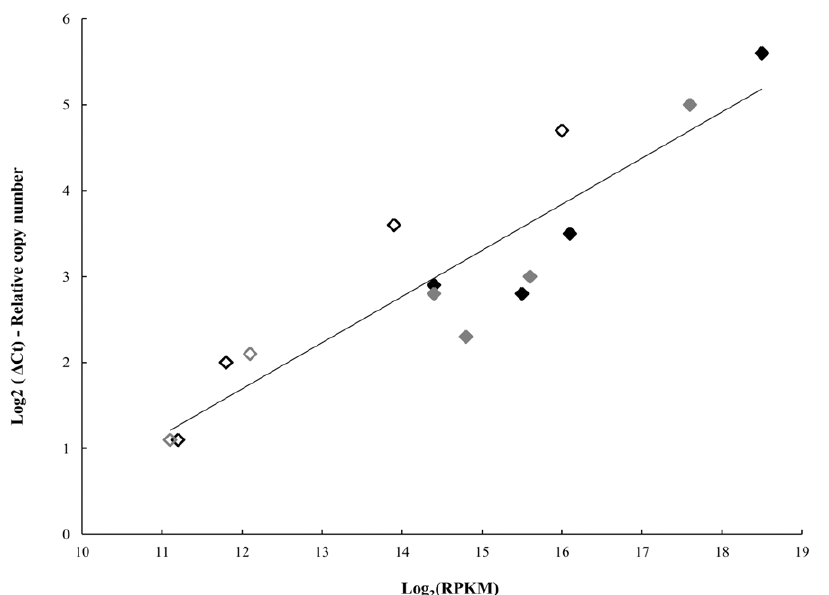
Figure 4. Correlation between RNA-seq and qRT-PCR. Plot demonstrating the relative quantification of 10 unlinked genes by qRT-PCR (y-axis) and the transcript levels generated by RNA-seq (x-axis). Genes commonly expressed by the pathogenic ( ¤ ) and non-pathogenic ( ¤ ) variants. Genes exclusively expressed by the pathogenic ( e ) and non-pathogenic ( e ) variants.